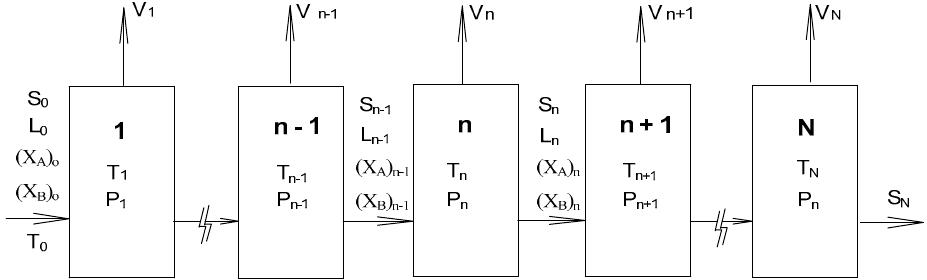
Figure 1. Schematic diagram of the stripping crystallization (SC) operation where each stage is operated at a three-phase transformation state.